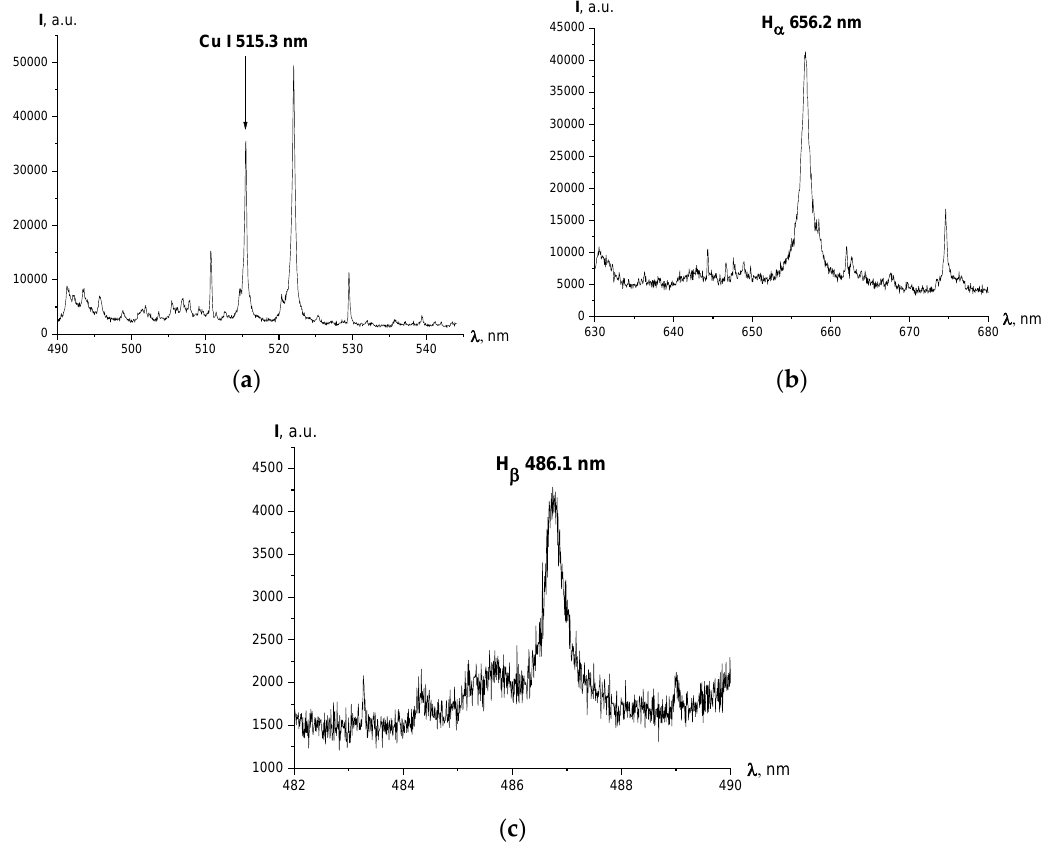
Figure 2. Typical spectra obtained throughout the experiments (cross-section of the arc halfway between the electrodes); exposure time of the EMCCD τ = 200 μs: ( a ) spectrum of Cu I lines registered for I = 450 A, central wavelength λ = 515.0 nm, grating 300 lines/mm; ( b ) H α line registered for I = 450 A, central wavelength λ = 616.5 nm, grating 300 lines/mm; ( c ) H β line registered for I = 660 A, central wavelength λ = 486.1 nm (Hβ line wasn’t registered for the current regime of 450 A due to its low intensity), grating 1800 lines/mm.